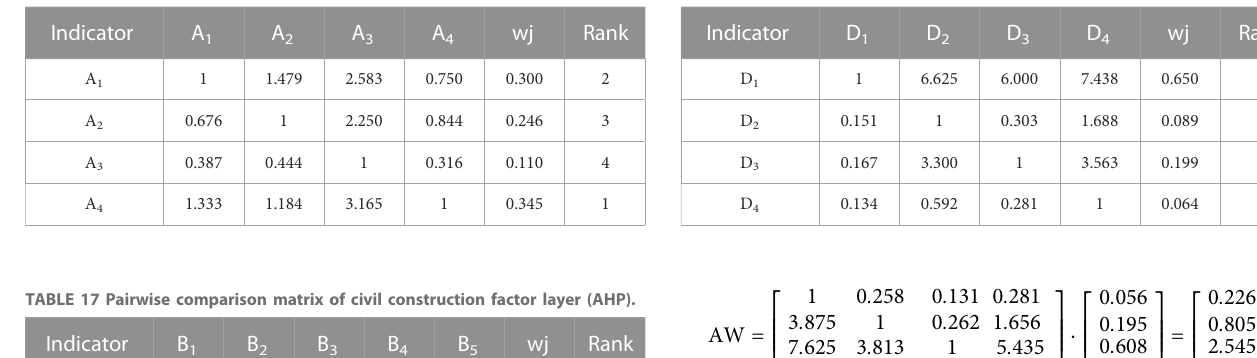
TABLE 19 Pairwise comparison matrix of acceptance factor layer of commissioning and power supply department